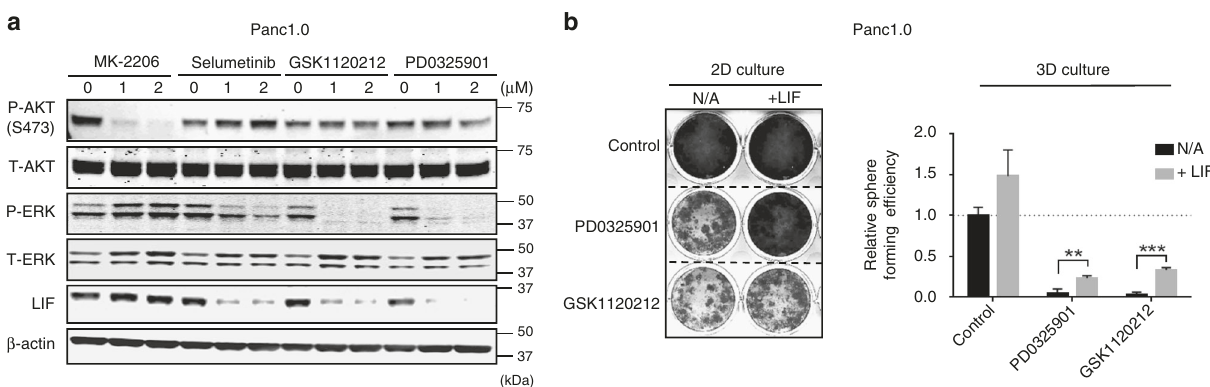
Fig. 2 Inhibition of MAPK-signaling pathway represses expression of LIF. a Representative western blots showing the amounts of LIF, phosphorylated ERK and phosphorylated AKT in Panc1.0 cells. Inhibition of the MAPK-signaling pathway by small molecules selumetinib, GSK-1120212, and PD0325901 suppressed the expression of LIF, whereas inhibiting the activity of AKT by MK-2206 did not. The inhibitory ef fi ciency of the small molecules was con fi rmed by the phosphorylation levels of AKT at S-473 and the phosphorylation of ERK. The cells were treated with compounds for 48 h before harvested for western blot analysis. b Growth of Panc1.0 in 2D and 3D culture suppressed by MEK inhibitors, GSK-1120212, or PD0325901 at 1 µ M. The suppression of growth can be rescued by adding LIF in culture medium. Crystal violet staining was used to visualize cell growth in 2D culture. Sphere formation assay was used to determine the growth in 3D ( N = 6; ** P < 0.01; *** P < 0.001). Error bar represents the standard deviation and P -value